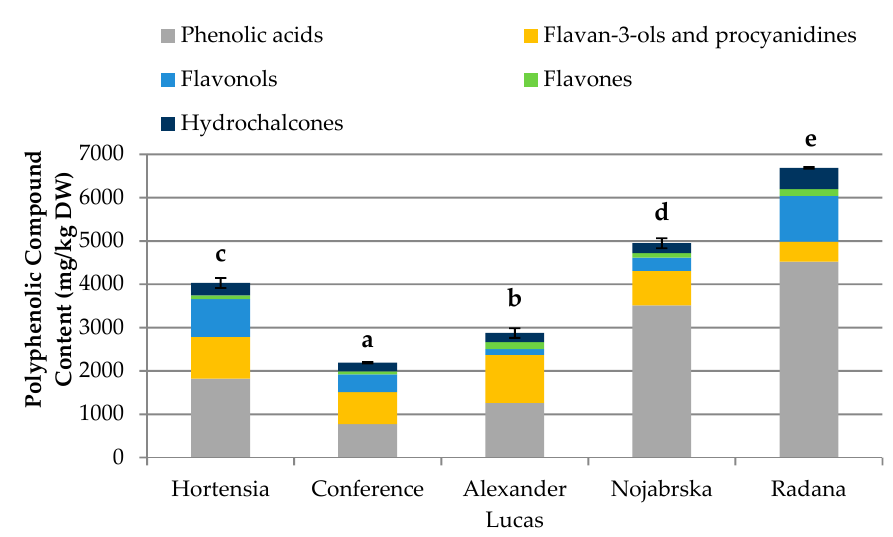
Figure 1. Content of polyphenolic compounds (mg/kg dry weight (DW)) in the pear cultivars. Varieties with different letters were significantly different at p = 0.05 according to Duncan’s test. The data are expressed as mean ± SD ( n = 9).